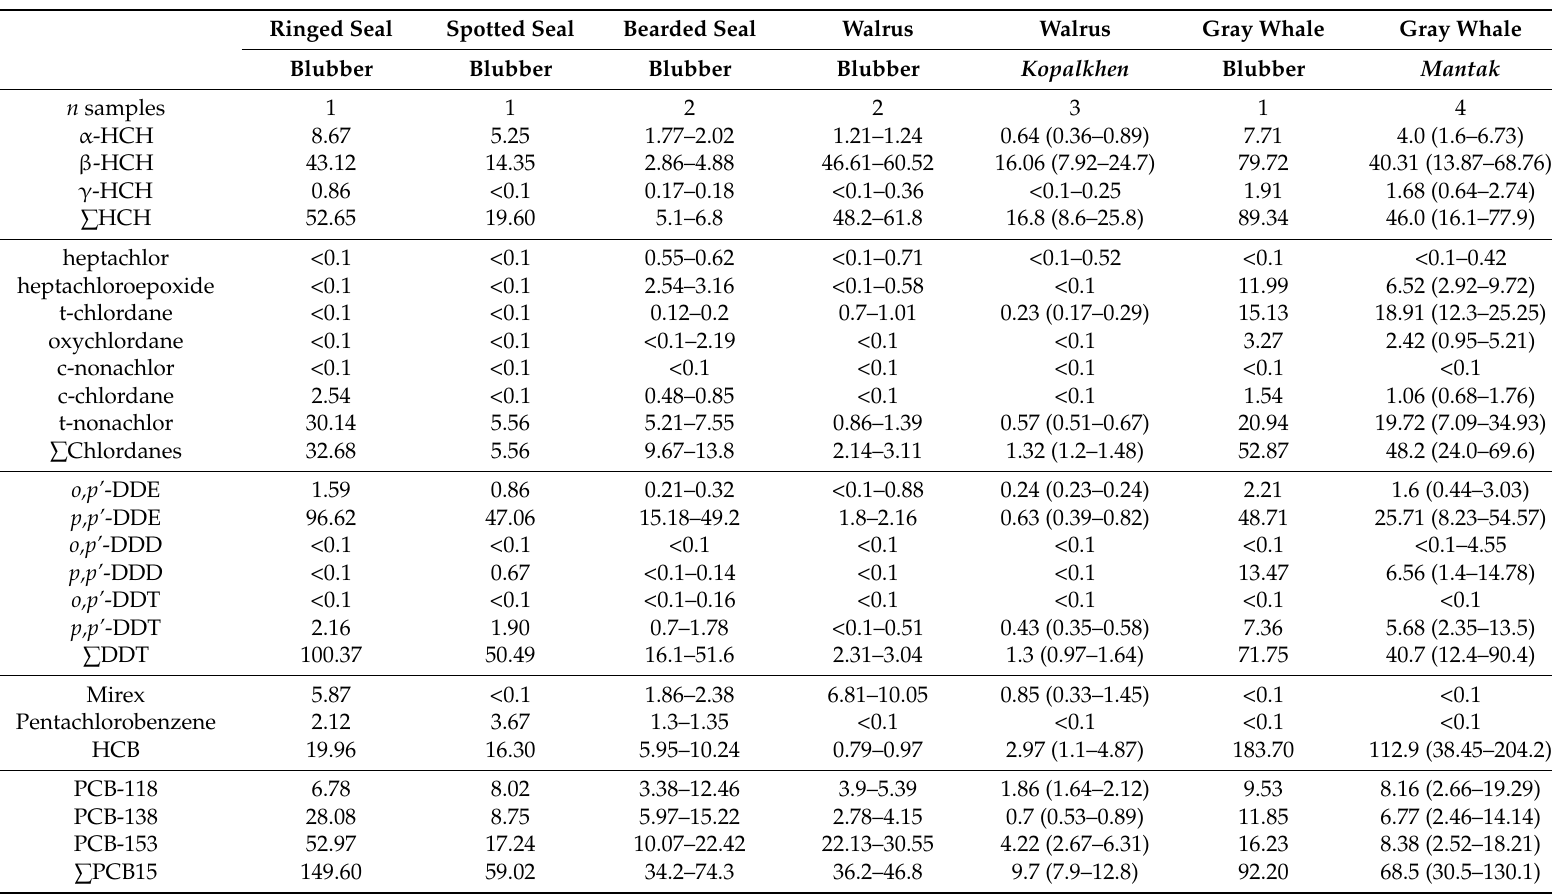
Table 2. POP concentrations in marine mammal blubber, collected in Chukotka Providensky district in April 2016. Levels, average levels (range), ng/g